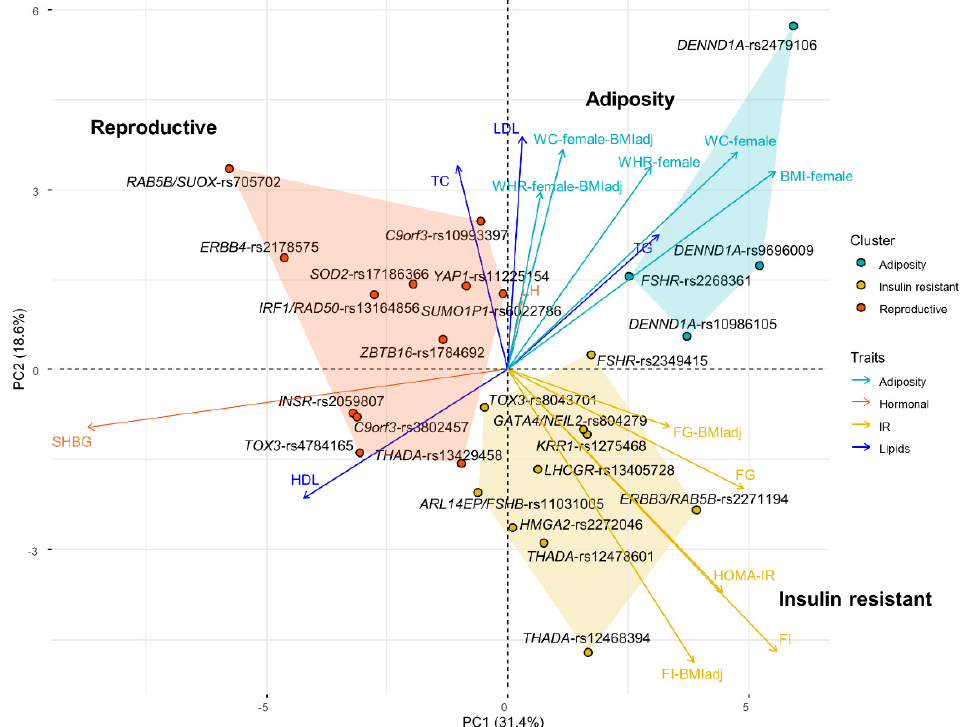
Figure 1. PCA plot of the variant–trait associations for PCOS variants. PCOS variants are plotted on the first 2 principal components (PCs) of the association Z-score and colored by the assigned clusters. The relative magnitude and direction of trait correlation with the PCs are shown with arrows. BMI, body mass index; WC: waist circumference; WHR: waist–hip ratio; PC, principal component; PCA, principal component analysis; FG: fasting glucose; FI: fasting insulin; SHBG, sex hormone binding globulin; LH, luteinizing hormone; HOMA-IR: homeostatic model assessment of insulin resistance; FI: fasting insulin; FG: fasting glucose; HDL: high-density lipoprotein; LDL: low-density lipoprotein; TC: total cholesterol; TG: triglycerides. Table 1. The association of the genetic risk score of each cluster with traits and disease outcomes.